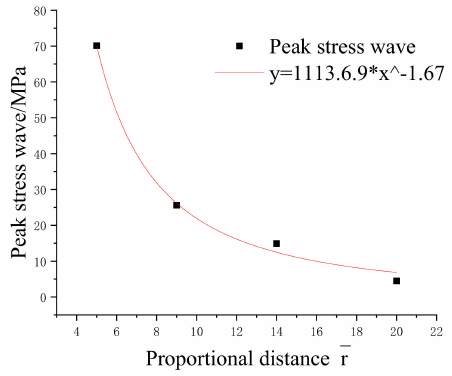
Figure 6. Stress wave attenuation law under high-energy gas action.